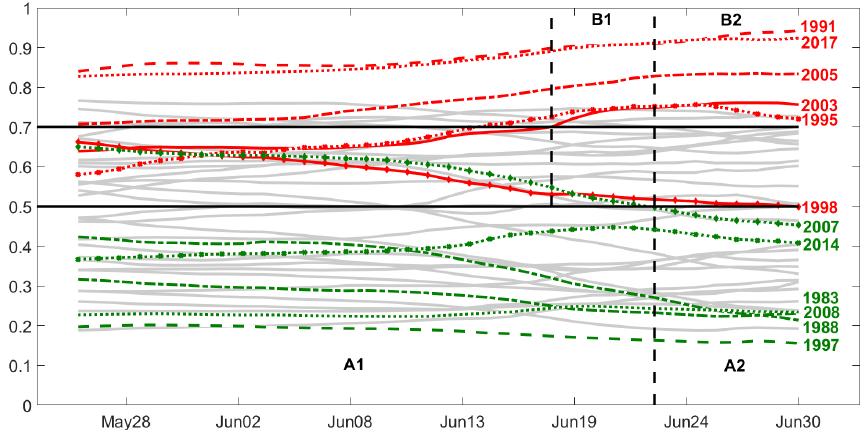
Figure 5. Temporal evolution of P exc (ψ, χ) during the pre-fire season (26 May to 30 June). Severe (weak) years are identified by the red (green) curves. The black horizontal lines represent thresholds used in Type A ( P exc = 0 . 5) and Type B ( P exc = 0 . 7) decisions. Vertical dashed lines delimit the phase where Type A and Type B decisions were checked.